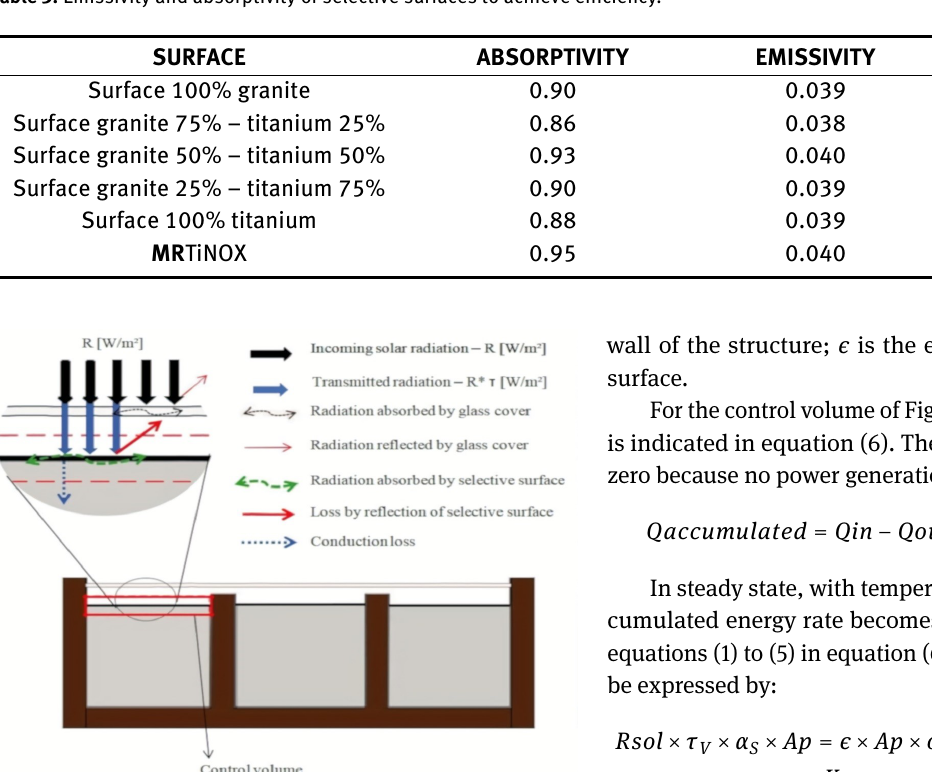
Table 3: Emissivity and absorptivity of selective surfaces to achieve eflciency.